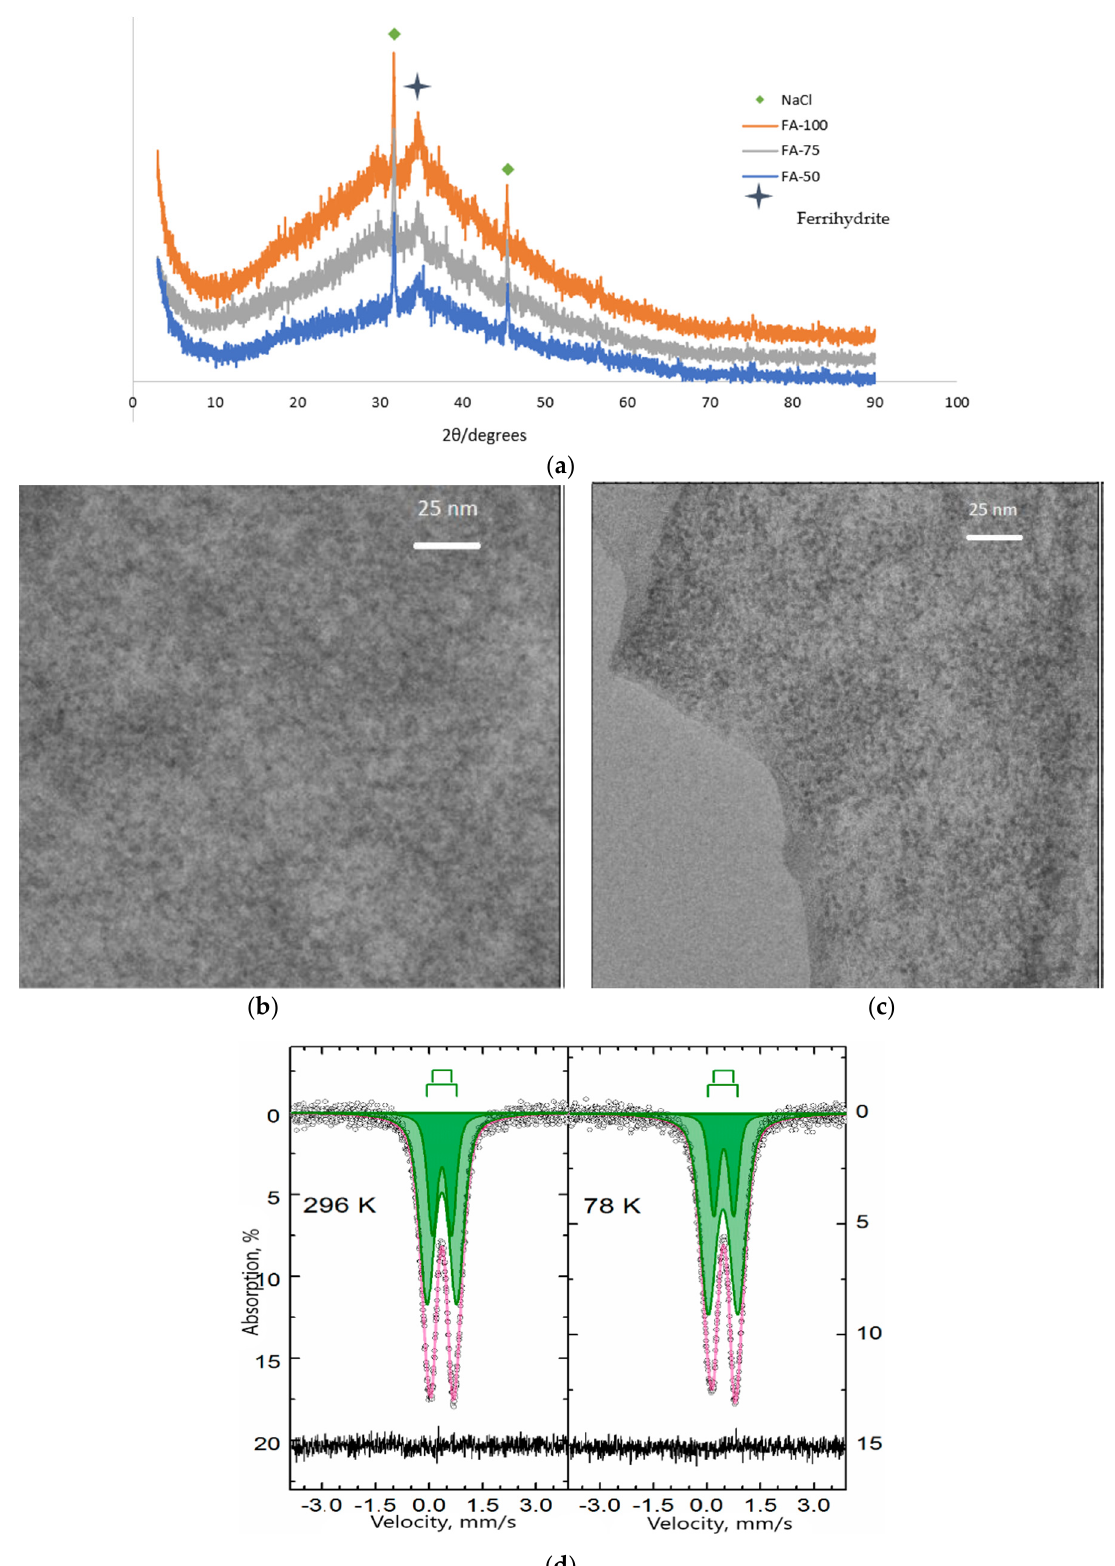
Figure 1. Characterization of Nano Iron samples ( a ) X-ray diffraction patterns: FA-100 is highlighted with orange; FA-75—gray; FA-50—blue colors. The peaks of NaCl are marked with green rhombuses. The ferrihydrite broad peak is marked with an asterisk, ( b ) TEM image of FeOOH in fulvic acid (FA-100), ( c ) TEM image of FeOOH in fulvic acid and maltodextrin (FA-50), ( d ) The Mössbauer spectra of fulvic acid FeOOH at room and liquid nitrogen temperatures.